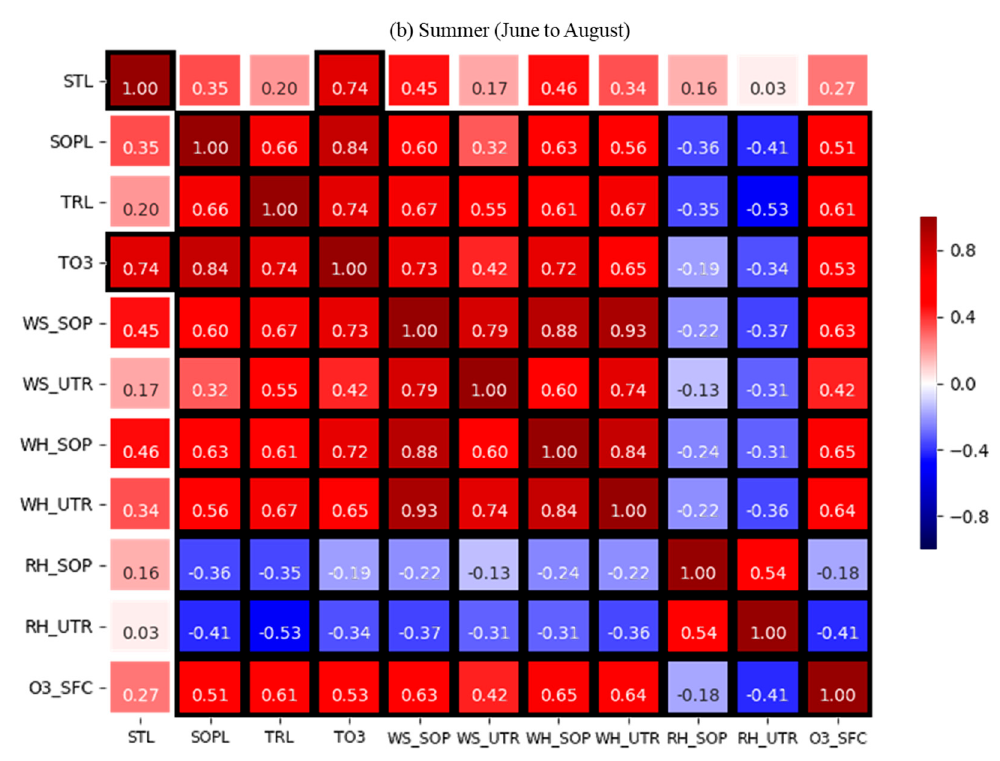
Figure 4. Correlation heatmap of each component (STL: stratospheric layer, SOPL: second ozone peak layer, TRL: tropospheric layer, TO3: total ozone, WS_SOP: wind speed of SOPL, WS_UTR: wind speed of the upper troposphere (3–9 km), WH_SOP: wind shear of SOPL, WH_UTR: wind shear of upper troposphere, RH_SOP: relative humidity of SOPL, RH_UTR: relative humidity of the upper troposphere, O3_SFC: surface ozone) for ( a ) spring, and ( b ) summer seasons. The black boundary line of each box represents the correlation values with a p -value < 0.05.